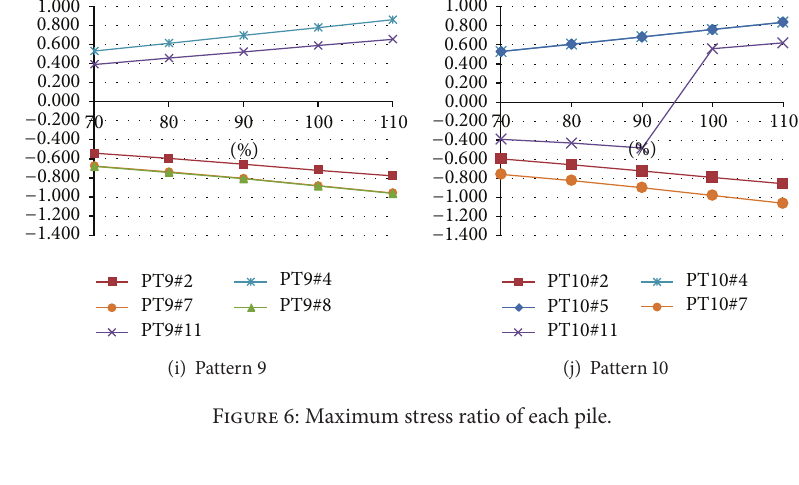
Table 6: Example of training